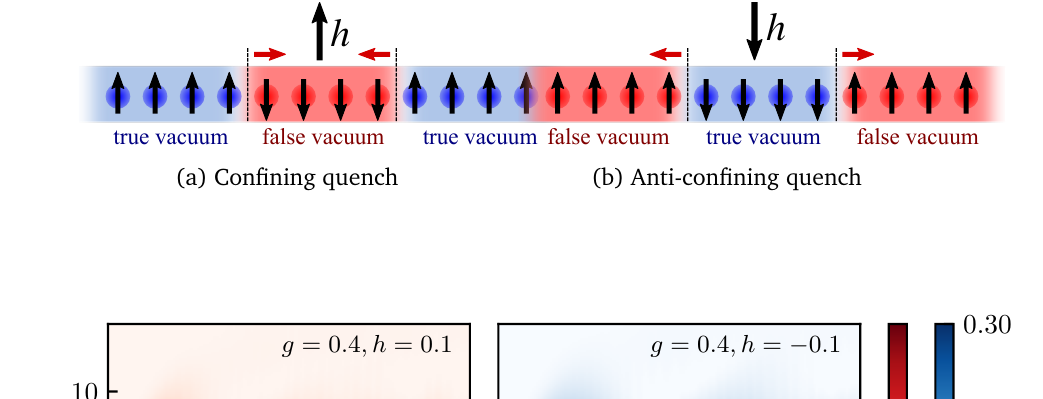
( l , t ) ≡ (cid:10) σ z ( t ) σ z ( t ) (cid:11) for z 0 l c